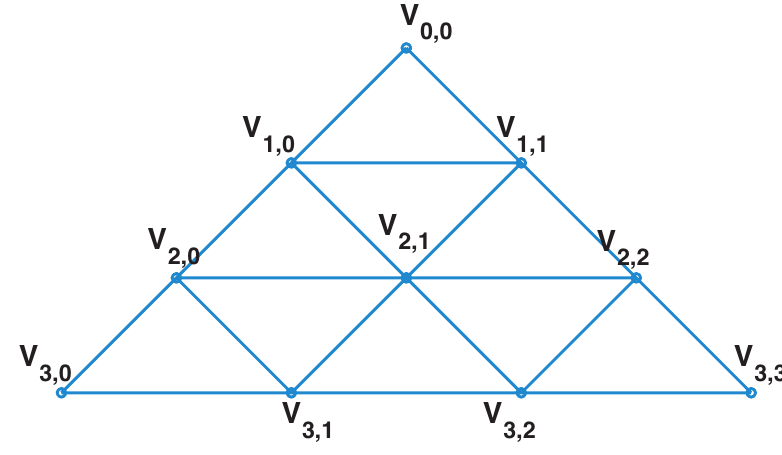
Figure 2: The topology of control mesh with m = 3 .